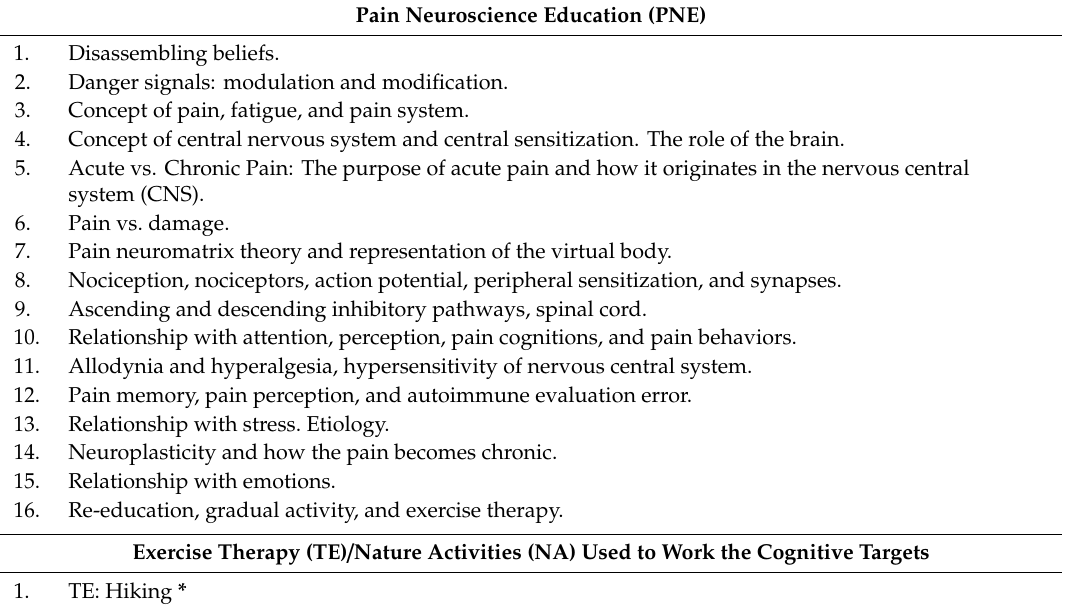
Table 2. Steps of the multicomponent treatment: PNE, exercise therapy, cognitive behavioral therapy (CBT), mindfulness and nature